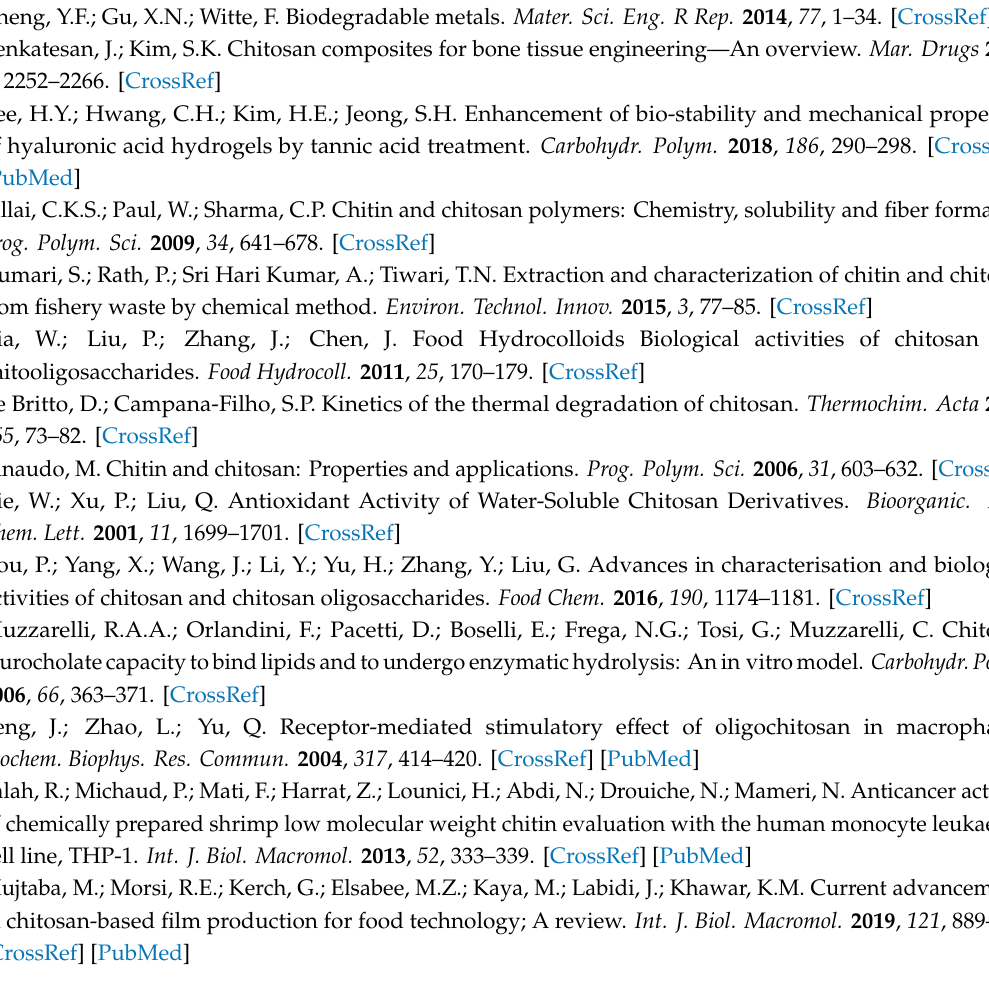
Figure S1: Possible interactions between CHT and PEGDE, CHT and GA. Figure S2: XPS scans for C, O and N, Figure S3: AFM 3D topography and